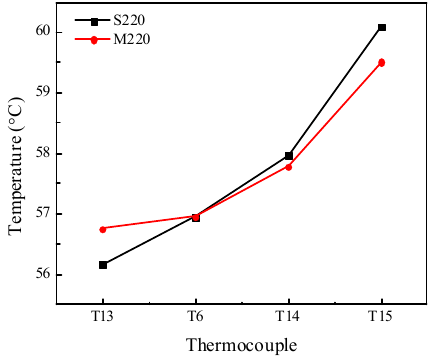
Figure 6. The axial temperature distribution in the load ‐ carrying area at 200 rpm ‐ 6 MPa.